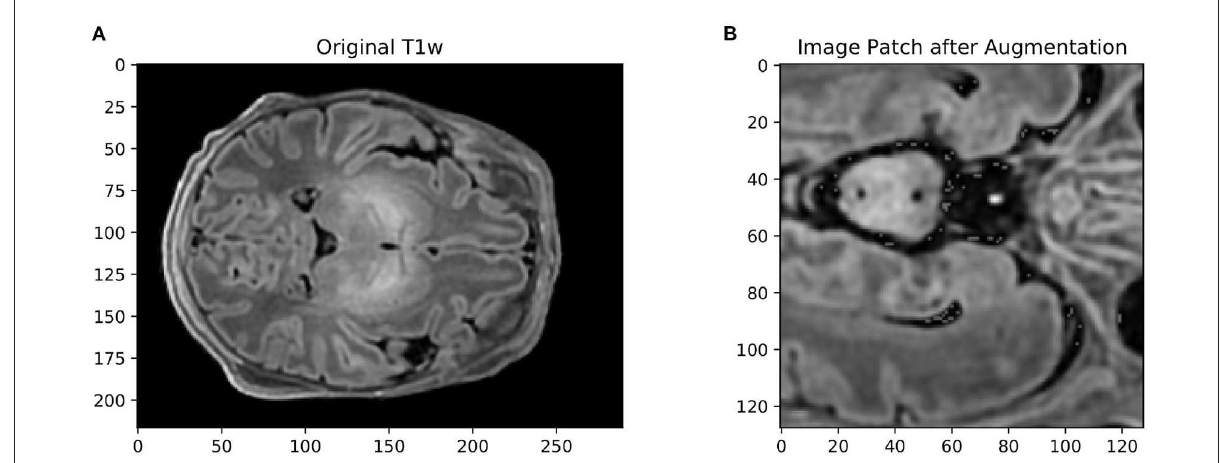
FIGURE2 (A) Example of an axial slice from a T1-weighted scan in the dataset, and (B) the same image after data augmentation The size of the original image was 217 × 290 × 290. The augmented image was first cropped to the size of the brain, then randomly cropped to 128 × 128 × 128, mirrored, elastically deformed, Gaussian noise and Gaussian smoothing added, and then voxel intensity scaled and